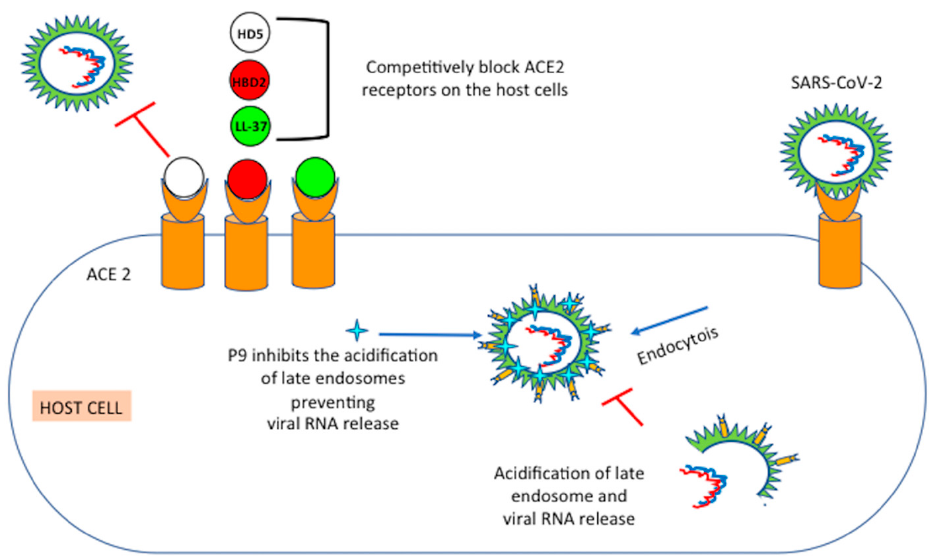
Figure 2. Mechanism of actions of some defensins with potential anti-SARS-CoV-2 activities. P9 peptide inhibits late endosomal acidification preventing viral RNA release. HD5, LL37 and HBD2 bind to ACE2 blocking its viral recognition and binding.